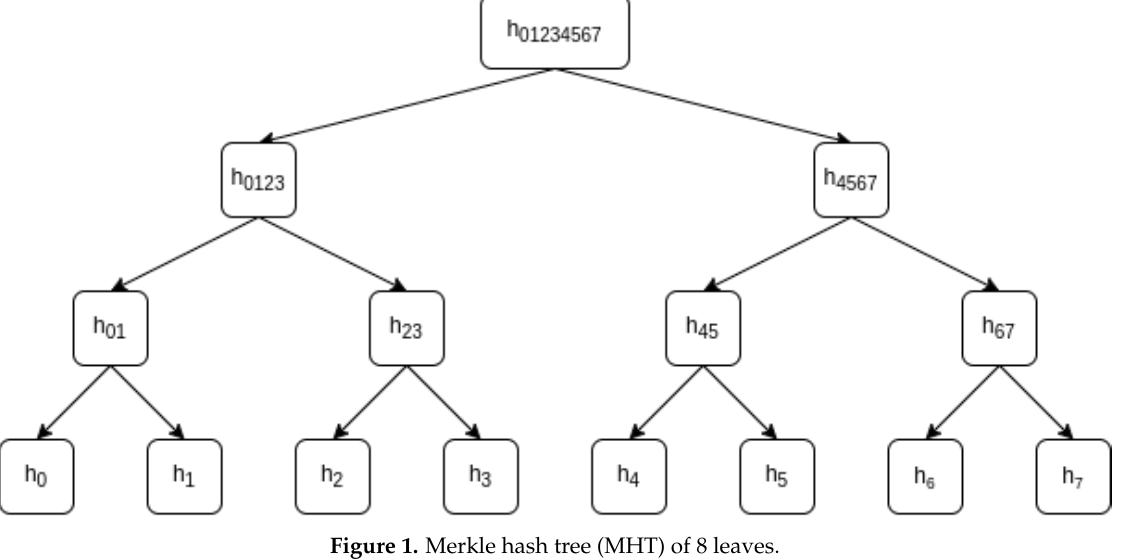
Figure 1. Merkle hash tree (MHT) of 8 leaves.